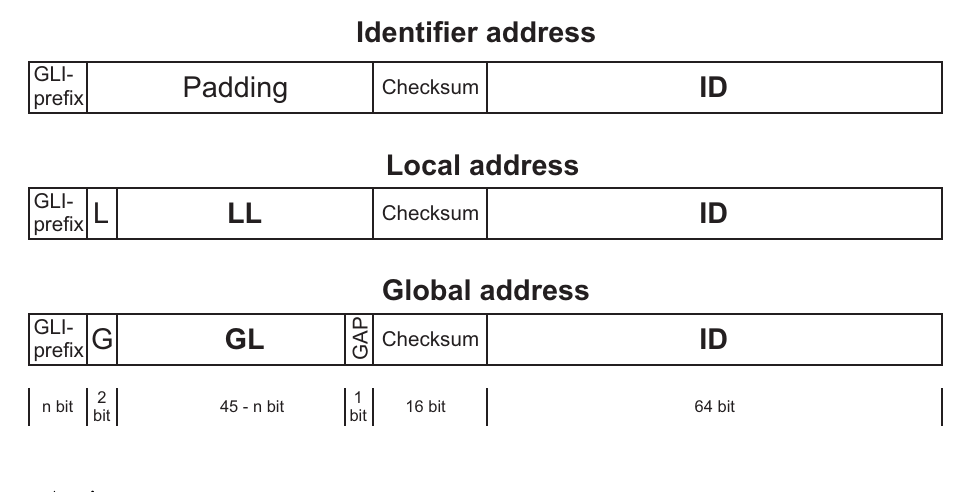
Figure 3. Three types of GLI-addresses are encoded in an IPv6